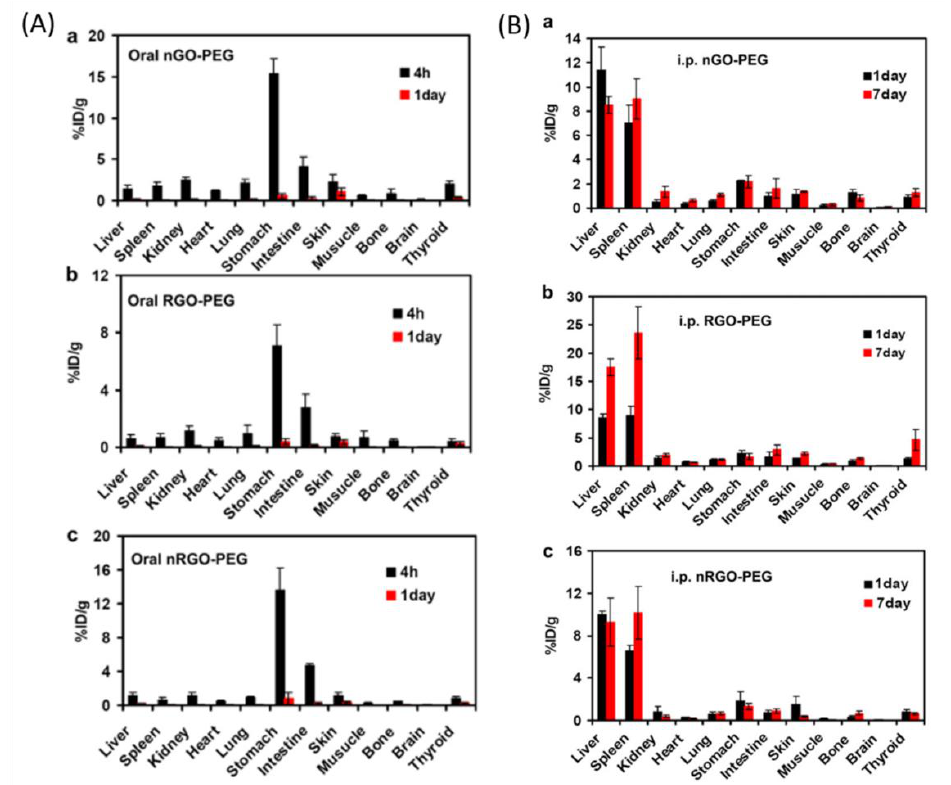
Figure 7. Biodistribution of (a) nGO-PEG, (b) RGO-PEG, and (c) nRGO-PEG after ( A ) oral administration and ( B ) intraperitoneal (i.p.) administration. Reproduced from Reference [238], with permission from Elsevier, 2013.